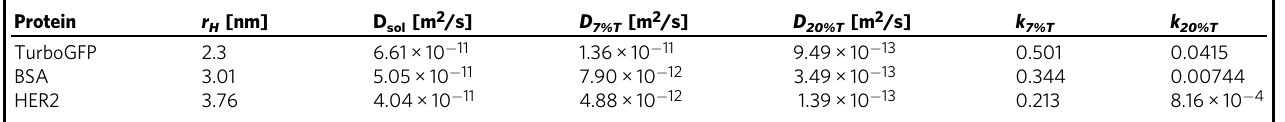
Table 1 Protein hydrodynamic radii ( r H ), diffusion coef fi cients ( D) and partition coef fi cients ( k ) used in fi nite-element modeling of diffusion during lysis and